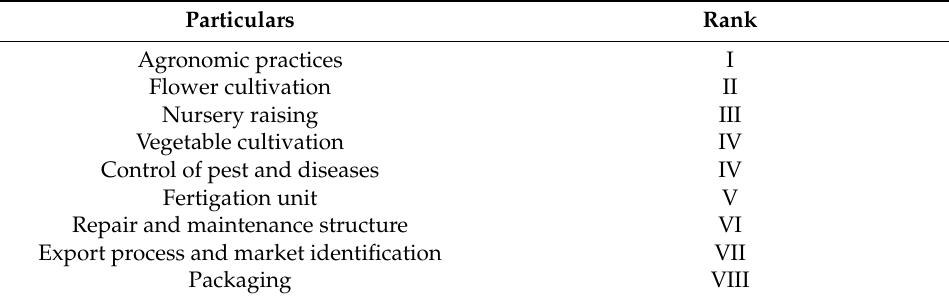
Table 24. Training needs of polyhouse